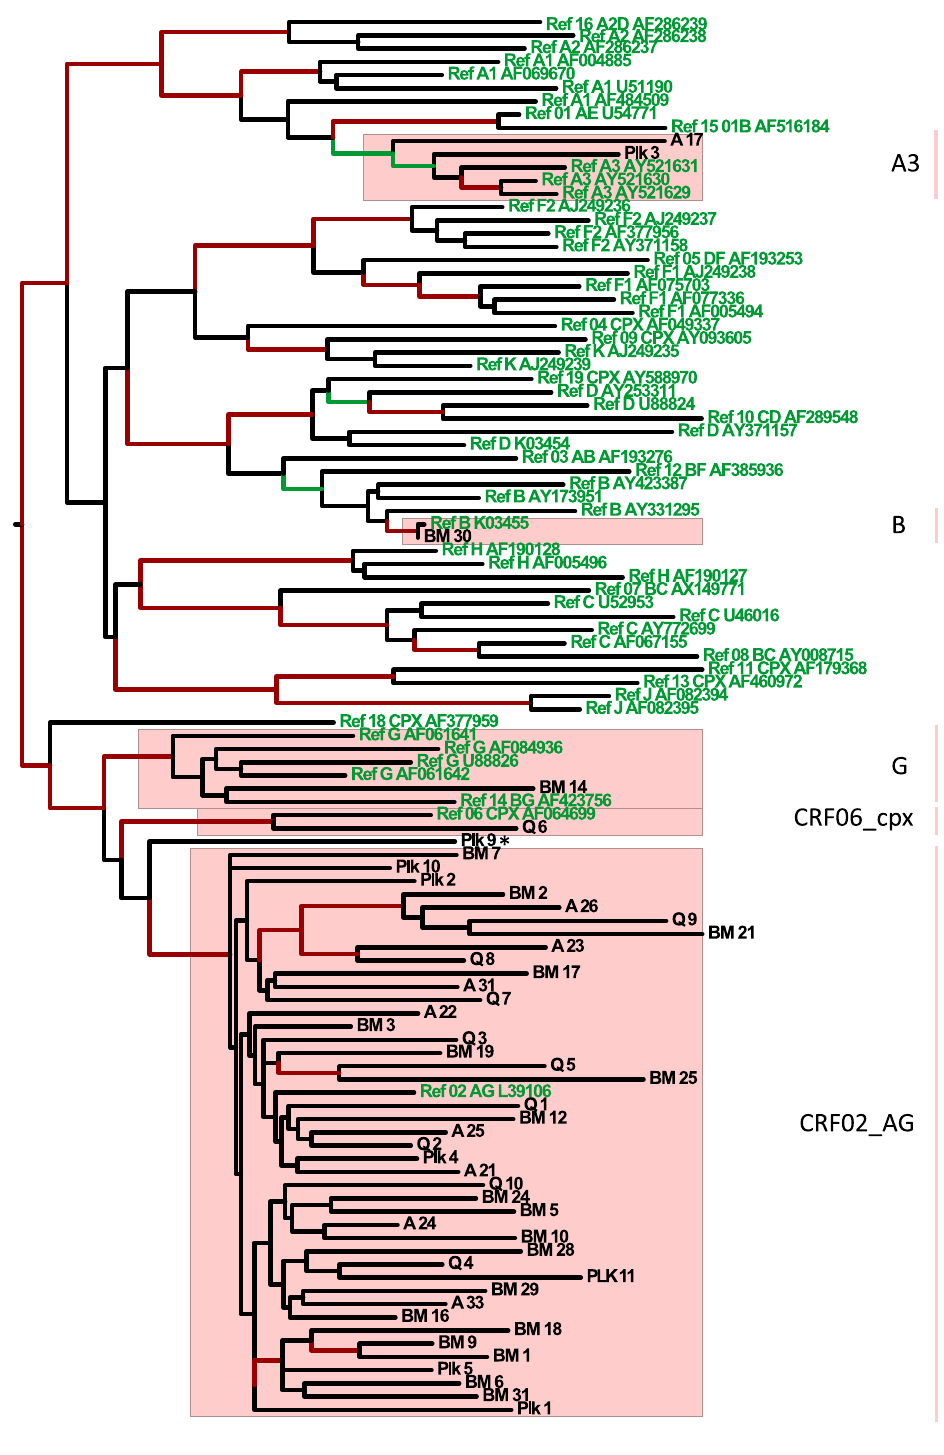
Fig 1. Maximum likelihood phylogenetic analysis of HIV-1 pol sequences (specimen names are indicated at tips in black font) from 48 women residing in Bissau, together with HIV-1 reference sequences (in green font), showed that sequences of the study participants belonged to five different subtypes/CRFs (highlighted within a box shaded pink, where the subtype/CRF names are shown to the right). One sequence (Plk_9) represented a putative recombinant between CRF06_cpx and CRF02_AG (indicated by an asterisk). Red internal branches indicate